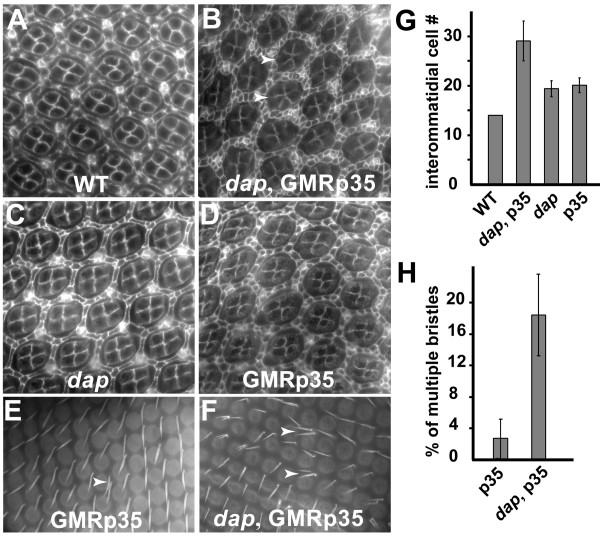
Dap mutant eye discs have increased number of interommatidial cells and bristles. Apical profiles of cells in the 48 h (A-D) and 55 h (E-F) APF pupal retinas stained with anti-Disc large antibodies. (A) Wild type retina. (B) dap mutant retina expressing the caspase inhibitor p35 under the control of GMR promoter (GMR-p35). (C) dap mutant retina. (D) Wild type expressing GMR-p35. (G) Quantification of the average number of interommatidial cells in WT, dap, GMR-p35, and dap mutant retinas expressing GMR-p35 is shown. (E-F) Phalloidin staining of pupae retina showing significantly more multiple bristles in dap mutant pupal retina expressing GMR-p35 (E) than in wild type retina expressing GMR-p35 (F). (H) Quantification of the incidence of multiple bristles in different genotype pupae discs is shown.